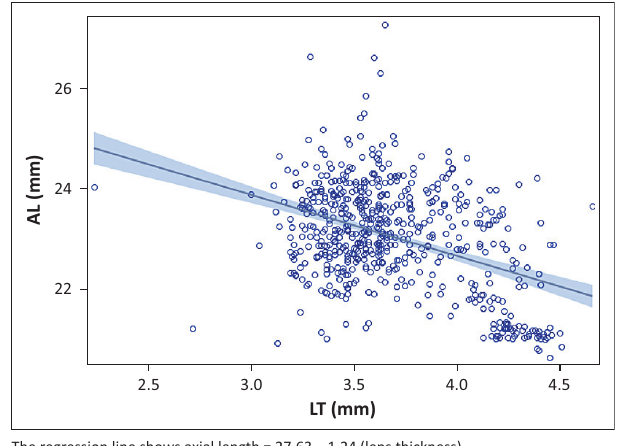
The regression line shows axial length = 27.63 – 1.24 (lens thickness). AL, axial length; LT, lens thickness. FIGURE 3: Scatter plot showing the relationship of axial length and lens thickness with 95 % confidence interval of the regression line ( R 2 = 0.17, r = -0.52, p = 0.000).